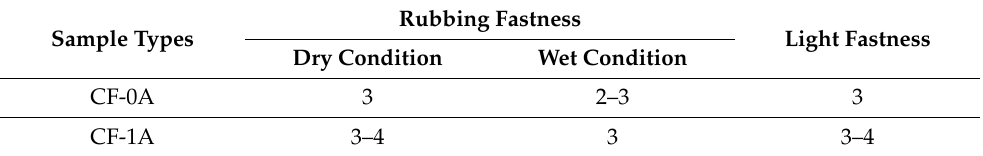
Table 8. Color fastness to rubbing and